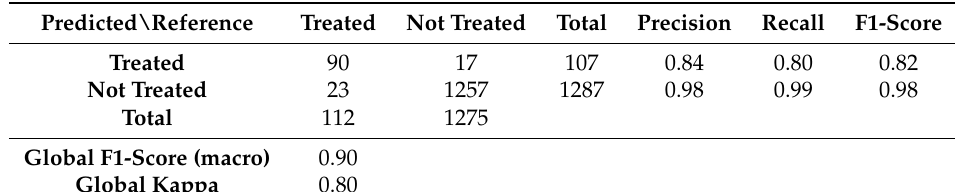
Table 3. Confusion Matrix for the algorithm RF using the DS_ALL data set.